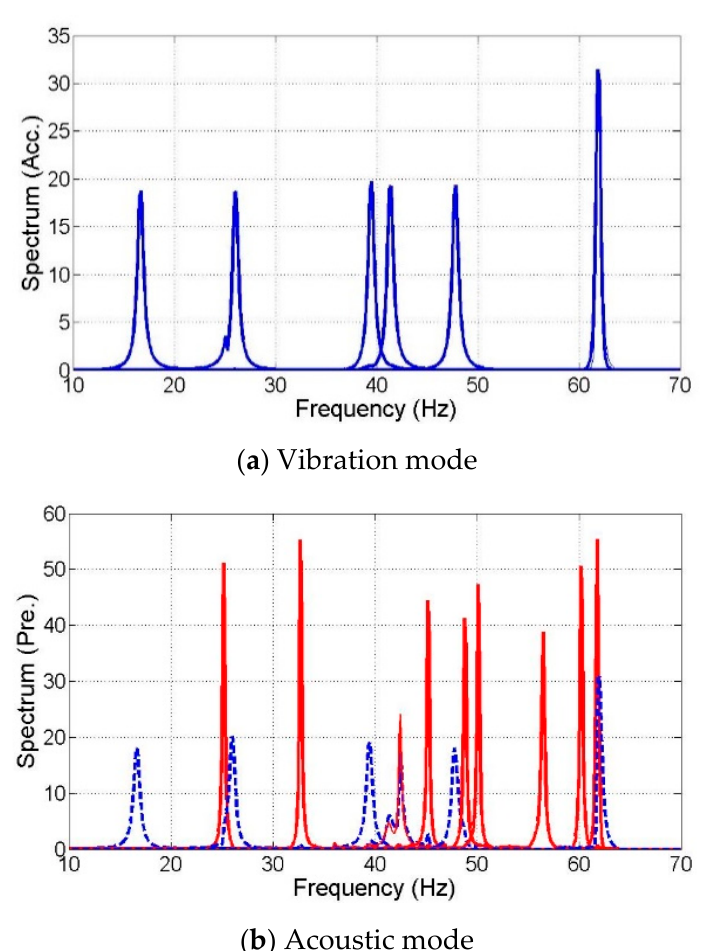
Figure 5. Power spectrum of modes: ( a ) Vibration mode from measured data; ( b ) Acoustic mode from vibration; The frequencies contained two modes. (1) Induced by vibration mode directly (blue dotted lines); (2) induced from vibro-acoustic coupling effect (red lines); (Dashed: vibration mode induced pressure. Solid: acoustic mode induced pressure).